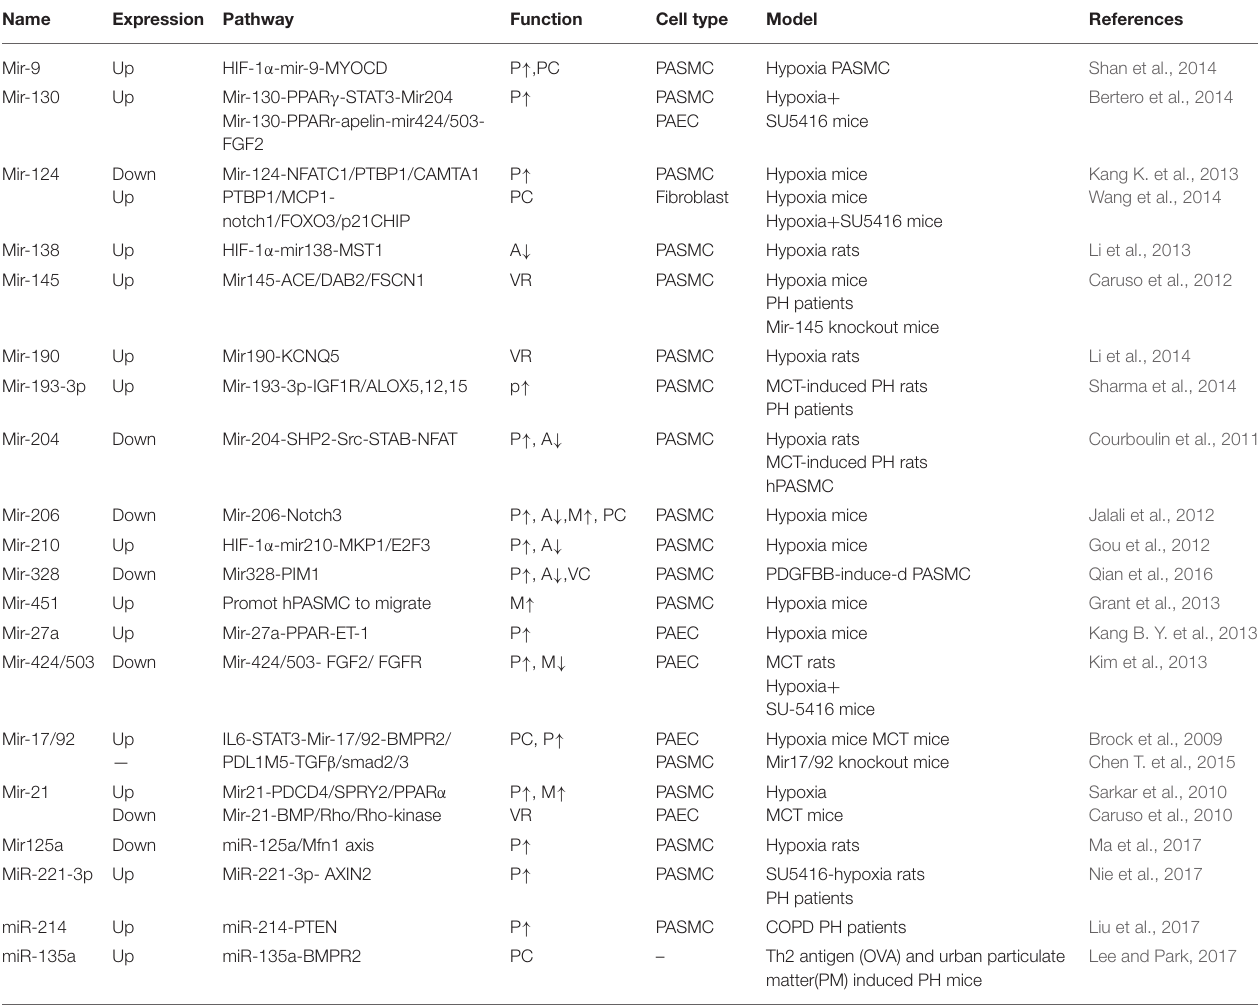
TABLE 3 | MicroRNA mechanisms in